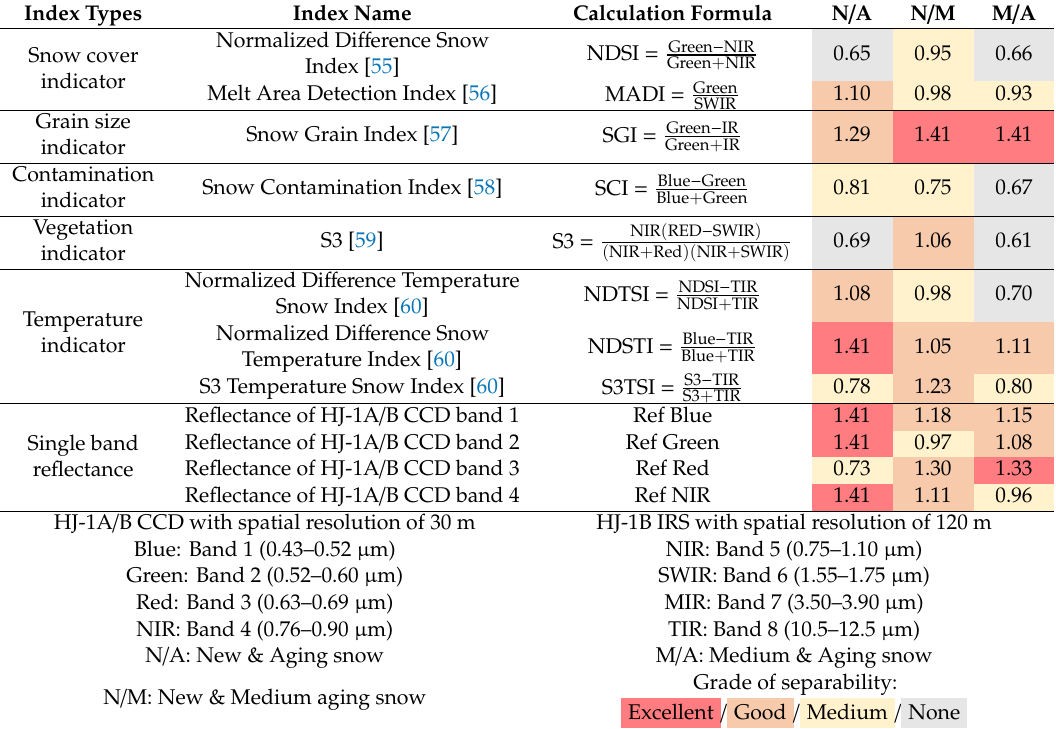
HJ-1A / B CCD with spatial resolution of 30 m HJ-1B IRS with spatial resolution of 120 m Blue: Band 1 (0.43–0.52 µ